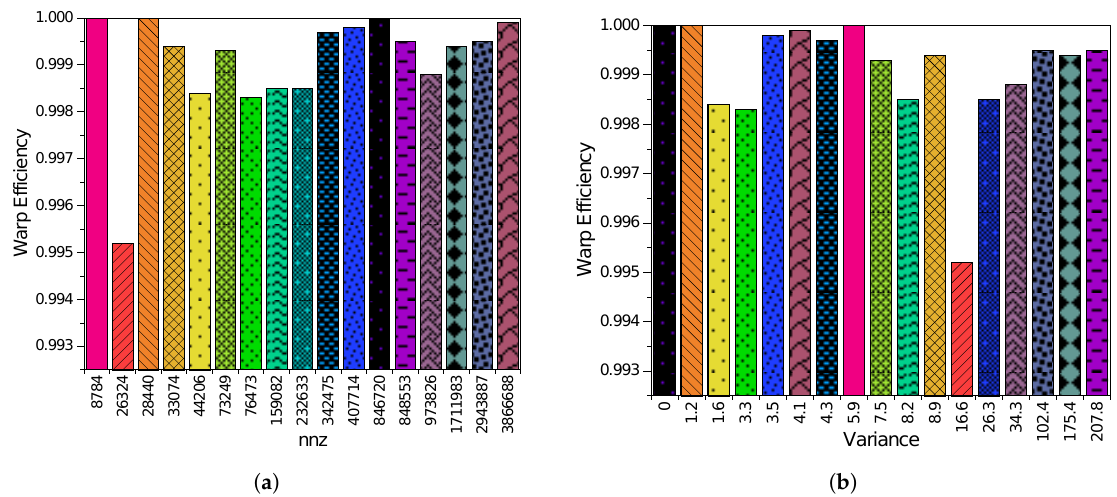
Figure 10. ELL warp efficiency against: ( a ) nnz and ( b ) npr variance